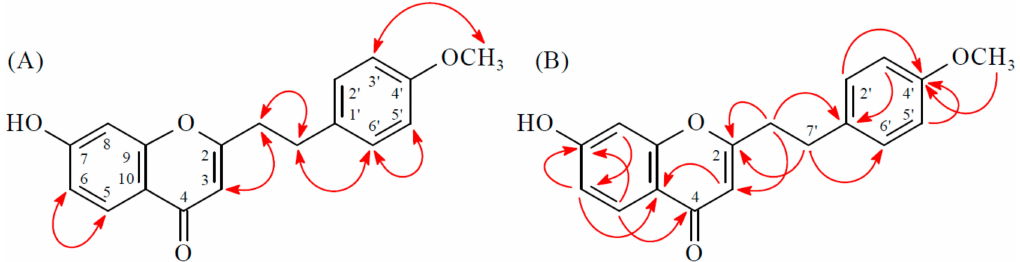
Figure 3. Key NOESY ( A ) and HMBC ( B ) correlations of 2 .